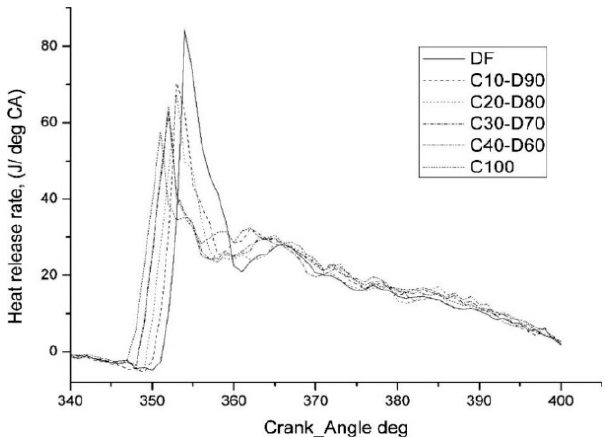
Figure 8. Heat release rate of Cymbopogon flexuosus biofuel [54].